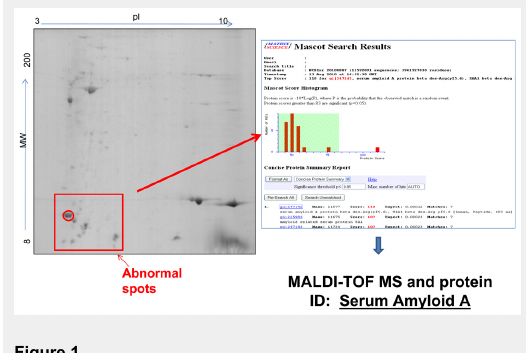
Typical 2D-PAGE map of fat tissue in AA amyloidosis. A 73-year old man presented with signs of renal and gastrointestinal amyloidosis. Immunohistochemistry classified the disease as ALκ type. However, due to the absence of a serum or urine monoclonal component, with normal serum free kappa light chains and κ/λ ratio, this result was considered inconclusive. Proteomic analysis by means of two-dimensional polyacrylamide gel electrophoresis (2D- PAGE, left panel) showed the presence of abnormal spots (in the box) that are not found in controls. Mass spectrometry analysis of excised spots, followed by data base search (right panel) characterized these spots as N-terminal fragments of SAA, allowing definite typing of